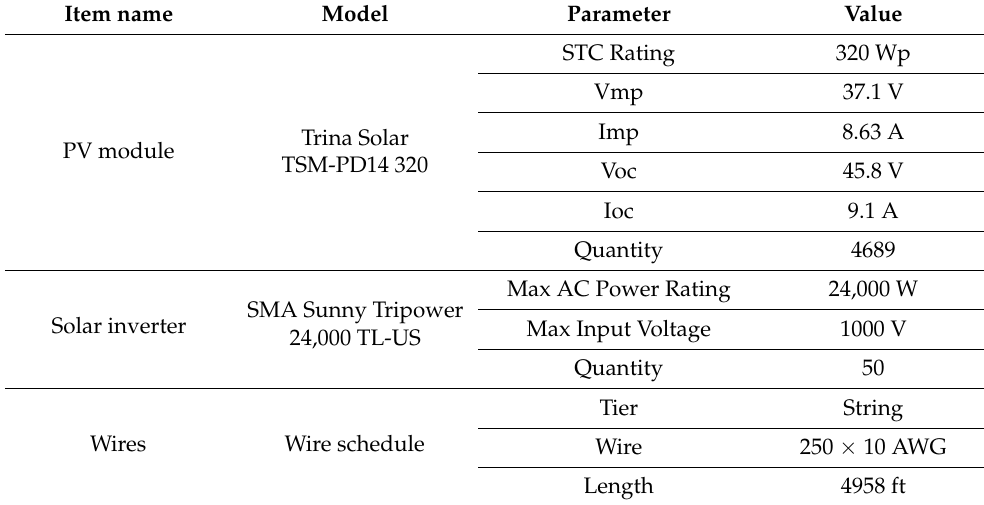
Table 1. Specifications of module, inverter, and wire schedule.